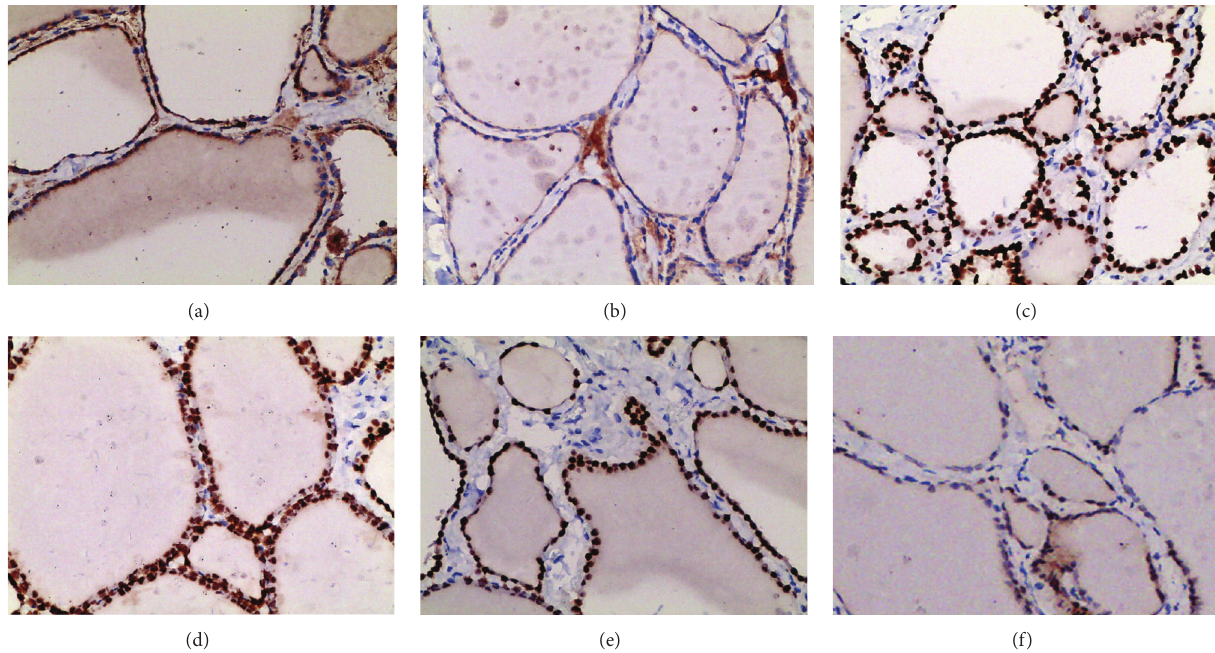
Figure2:ImmunohistochemicalanalysisoftheexpressionsandlocalizationofTSHR,TTF-1,andPAX8innodulargoiterandthecontrol.The high expression of TSHR in nodular goiter is shown in (a), the moderate expression of TSHR in the controls is shown in (b); the upregulation of TTF-1 in nodular goiter is shown (c), and the moderate expression of TTF-1 in the controls is shown in (d). The high expression of PAX8 in nodular goiter is shown in (e), and the moderate expression of PAX8 in the controls is shown in